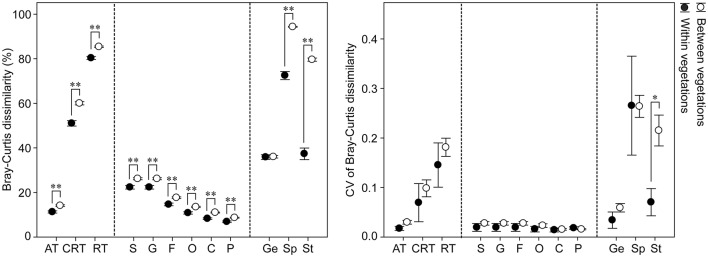
Pairwise Bray-Curtis dissimilarity of soil bacterial community and its coefficient of variation (CV) measured at different relative abundances, different taxonomic resolutions and different niche breadths. The bacterial community analyses are conducted on four vegetation zones: mudflat (n = 4), cordgrass (n = 4), ecotone (n = 4) and mangrove (n = 4). AT, abundant taxa; CRT, conditionally rare taxa; RT, rare taxa. S, species; G, genus; F, family; O, order; C, class; P, phylum. Ge, generalists; Sp, specialists; St, strict specialists (indicator species). Significance is calculated by nonparametric Mann-Whitney U-test. *P < 0.05, **P < 0.01. Data are expressed as means ± standard error (error bars).